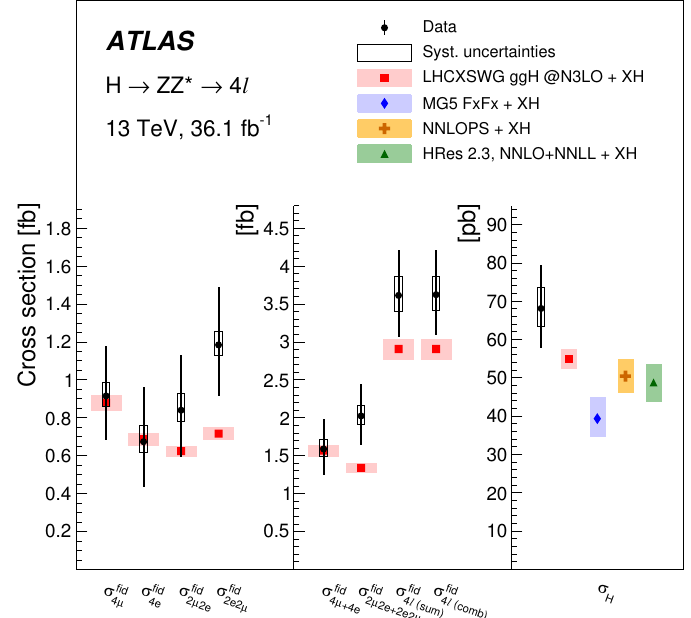
Figure 7. The (cid:12)ducial cross sections (left two panels) and total cross section (right panel) of Higgs boson production measured in the 4 ‘ (cid:12)nal state. The (cid:12)ducial cross sections are shown separately for each decay channel, and for same- and opposite-(cid:13)avour decays. The inclusive (cid:12)ducial cross section is measured as the sum of all channels, as well as by combining the per-channel measurements assuming SM ZZ (cid:3) ! 4 ‘ branching ratios. The LHCXSWG prediction is accurate to N3LO in QCD for the ggF process. For the (cid:12)ducial cross-section predictions, the LHCXSWG cross sections are multiplied by the acceptances determined using the NNLOPS sample for ggF and the samples discussed in section 3 for the other production modes. For the total cross section, the cross-section predictions by the generators NNLOPS , HRes , and MG5 aMC@NLO FxFx are also shown. The cross sections for all other Higgs boson production modes XH are added. The error bars on the data points show the total uncertainties, while the systematic uncertainties are indicated by the boxes. The shaded bands around the theoretical predictions indicate the PDF and scale